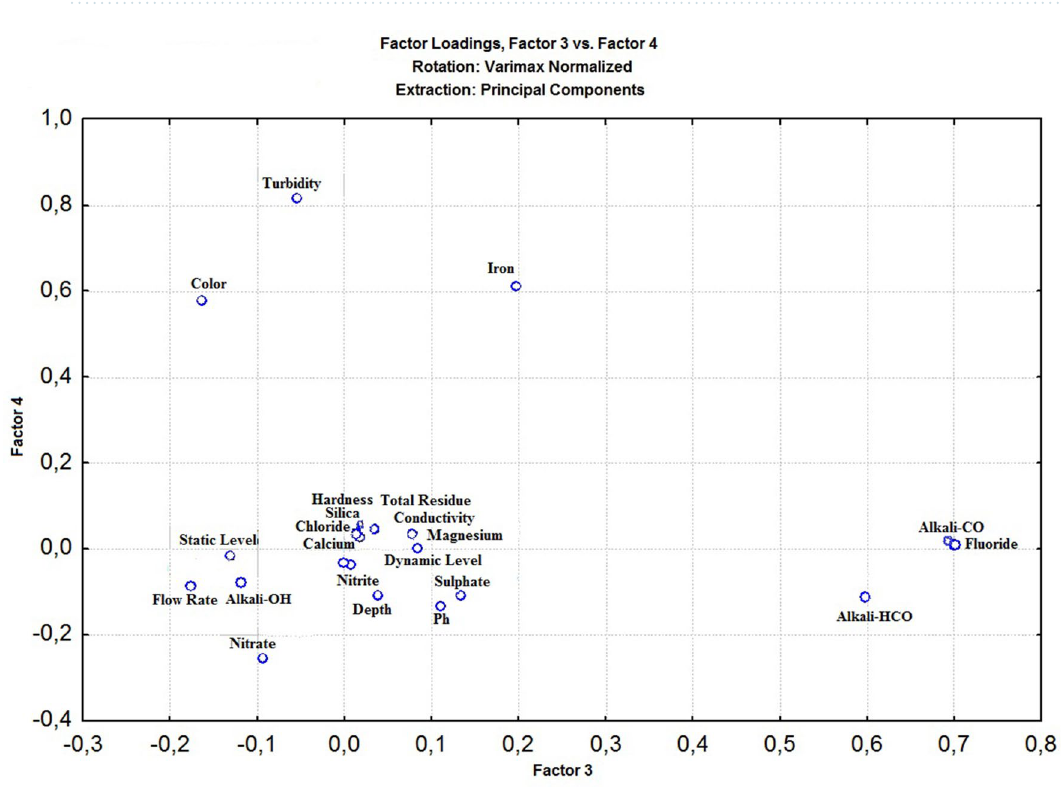
Figure 4. Graphical representation of factors F3 x F4 (Normalized Varimax Rotation), using Statistica, version 7.0 115